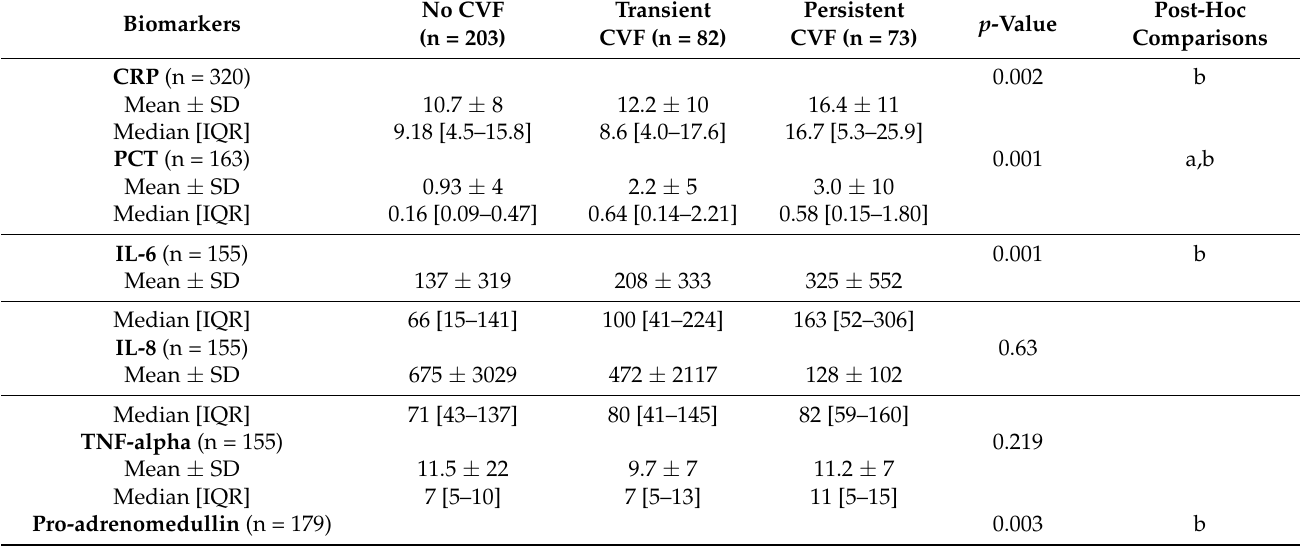
Table 4. Inflammatory response at Day